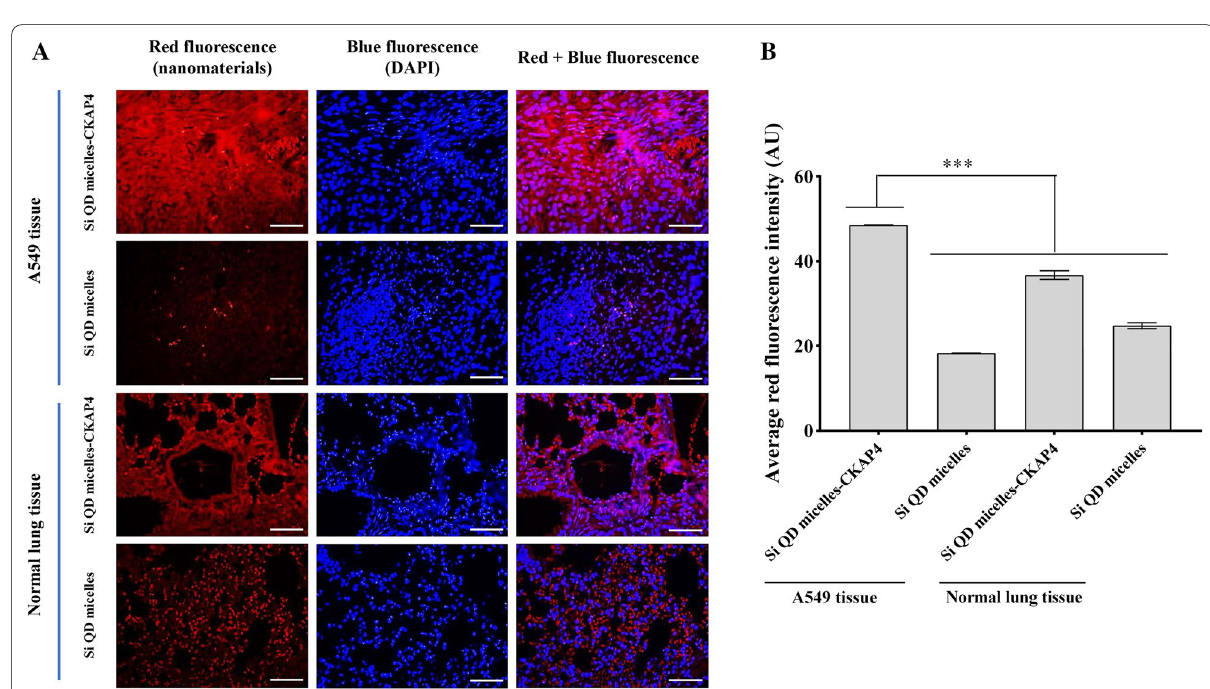
Fig. 5 Detection of the capability of Si QD micelles-CKAP4 targeting to A549 tissue in vitro. a A549 tissue and normal lung tissue were cultured with Si QD micelles-CKAP4 and Si QD micelles (the concentration of Si: 150 µg/ml) at 37 ℃ for 2 h. After washing twice, tissues were stained with DAPI to visualize nucleus. Tissues were pictured by confocal laser scanning microscope (Bar, 200 µm). b A quantitative analysis of mean red fluorescent intensity was measured by ImageJ ( n 3; mean SD; one-way ANOVA with Dunnett’s post test; *** P < = ±